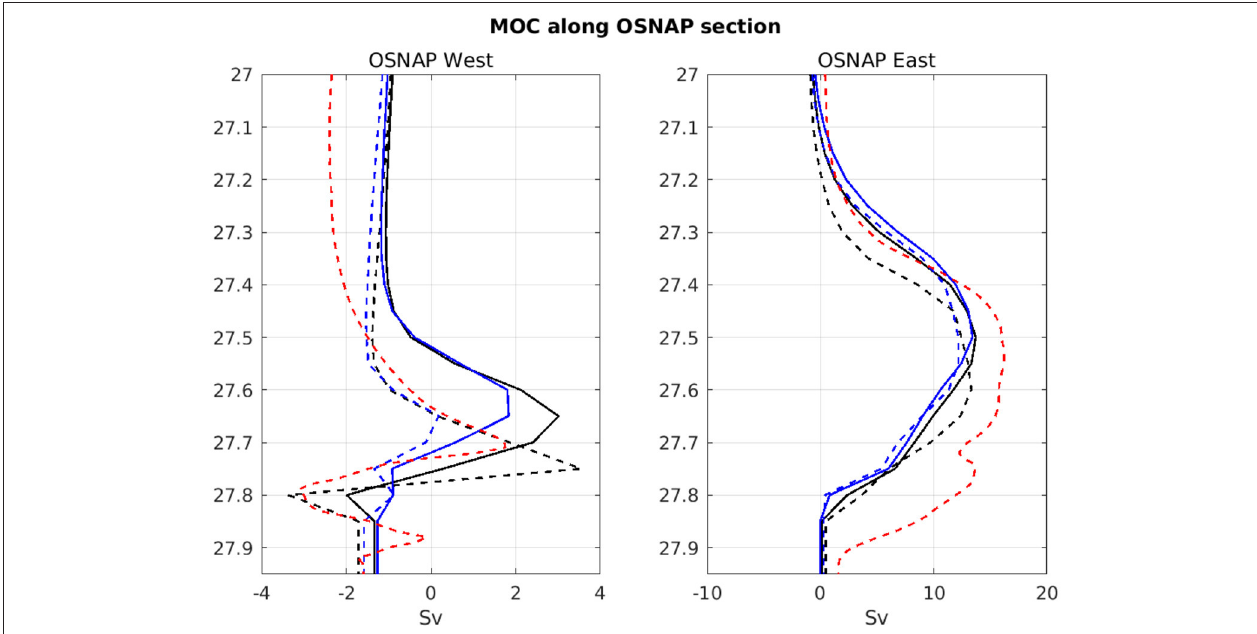
FIGURE 8 | MOC (in Sv) along the OSNAP array, west on the left and east on the right, computed in density (sigma 0, expressed in kg/m 3 ) space in the HR simulations. The thick black line stands for the average over the period 2004–2016 in control simulation, the thick blue line for the same average in the melting simulation. The dotted lines are showing the year 2015 in control (black), melting (blue), and observations (red) from Lozier et al. (2019).